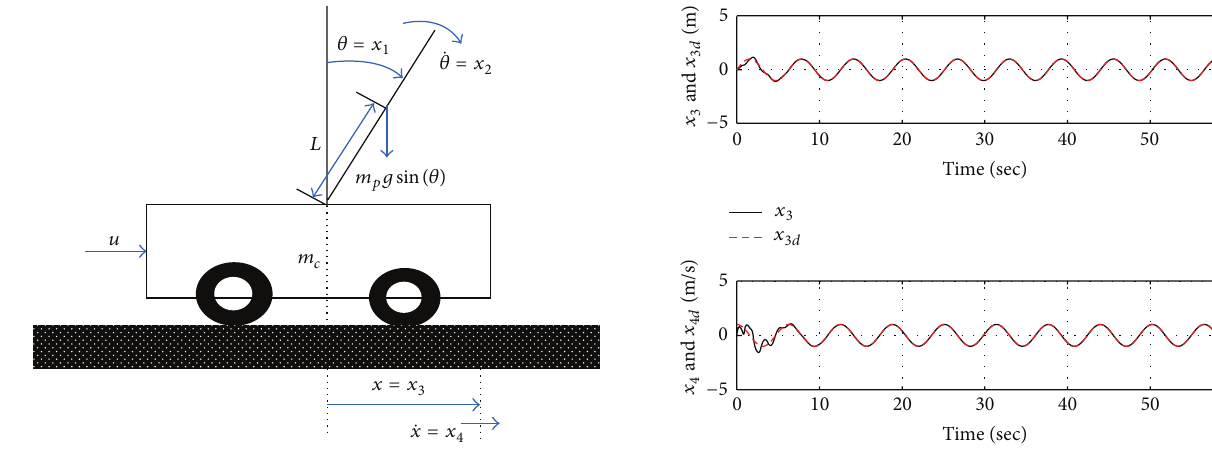
Figure 1: Movable cart with an inverted pendulum system.